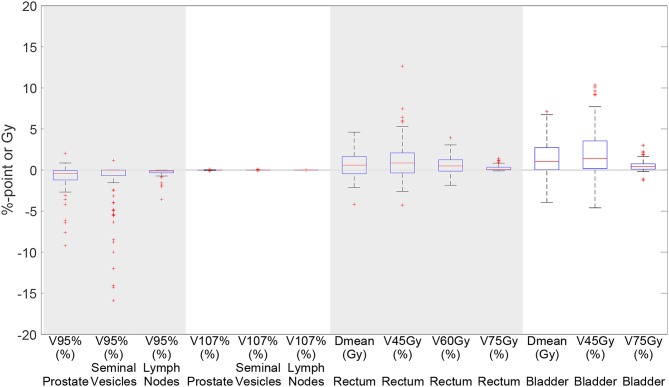
Boxplot depicting the difference in dosimetric parameters between the automatically generated delineations and the manual delineations in the treatment plan based on the automatically generated delineations using elastix 100 iterations for 93 scans. Each box plot indicates the median and the 25th and 75th percentiles of the obtained differences. The line depicts the remaining differences which are not outliers. Values are defined outliers if they are more than 1.5 times the distance between the 25th and 75th quartiles away from the quartiles. The red marks indicate the outliers.